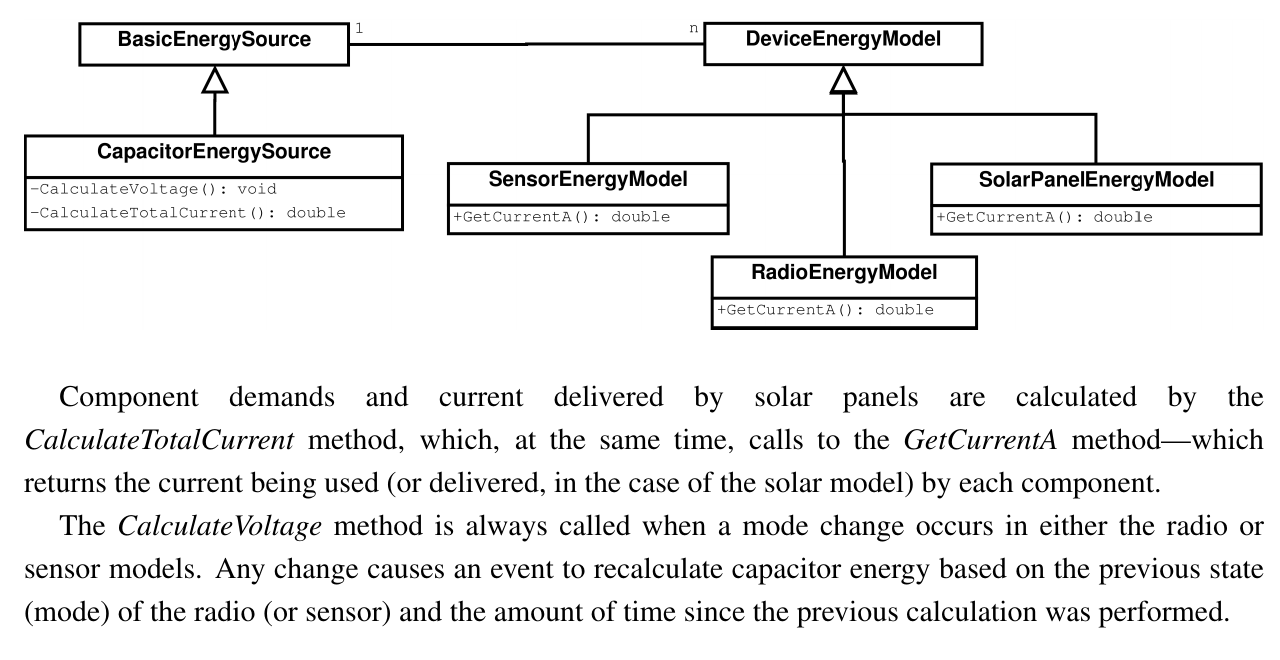
Figure 2. Simplified class diagram of the ns-3 energy